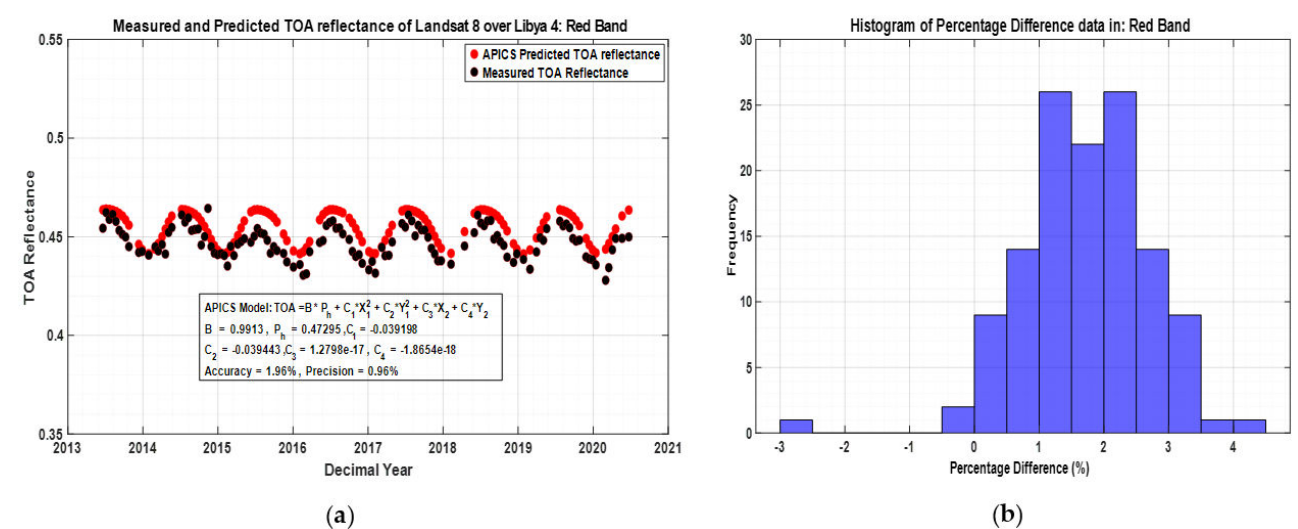
Figure 9. ( a ) L8 observation over Libya 4 (black circle) and model prediction (red circle) in Red band; ( b ) Percentage Difference analysis plots of the model in the Red band, Landsat